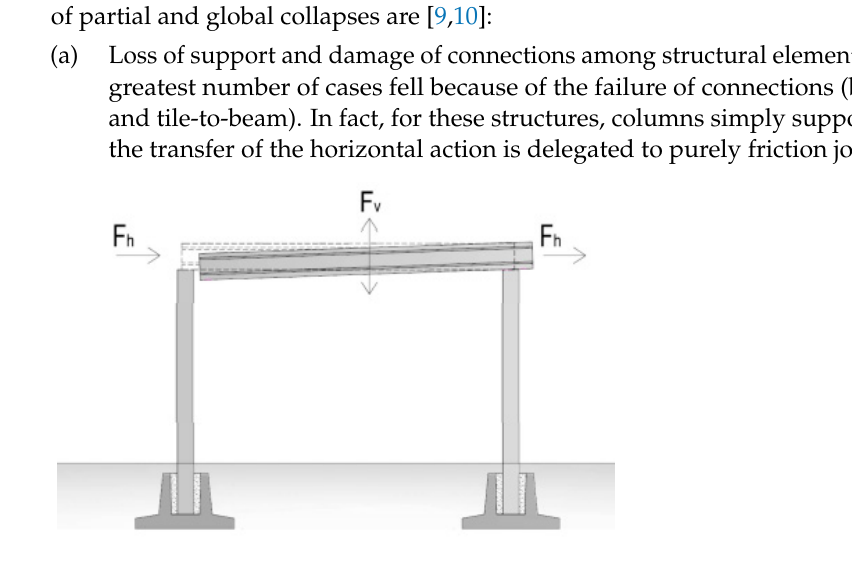
Figure 1. Precast RC frame with a simply supported